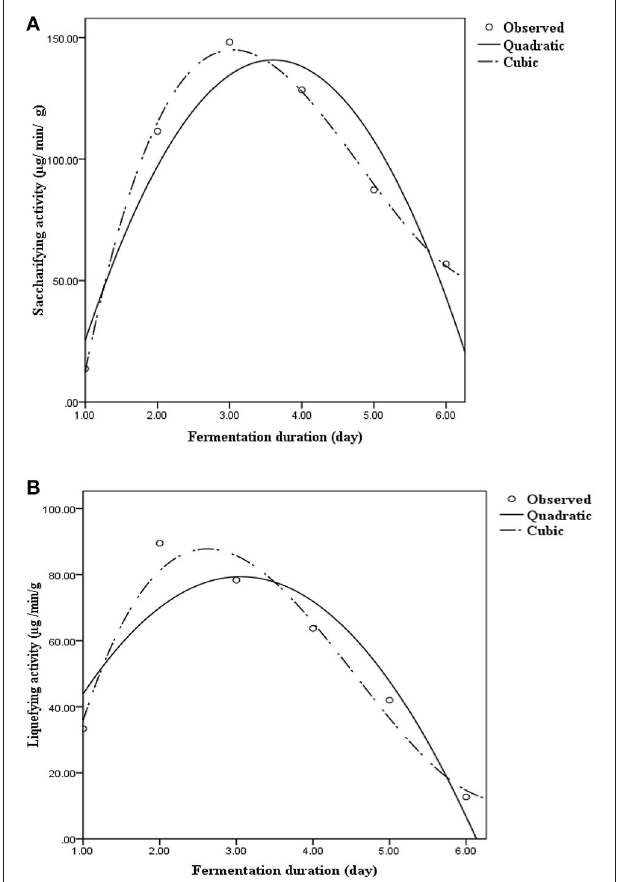
FIGURE 2 | Saccharifying and liquefying activity on various days during rice fermentation. Results are presented through quadratic and cubic regression with respect to day. (A) Saccharifying activity = − 80.133 + 122.605 × Day − 17.01 × Day 2 (R 2 = 0.900); Saccharifying activity = − 188.206 + 258.55 × Day − 62.04 × Day 2 + 4.24 × Day3 (R 2 = 0.997). (B) Liquefying activity = 1.03 + 51.25 × Day − 8.38 × Day 2 (R 2 = 0.851);